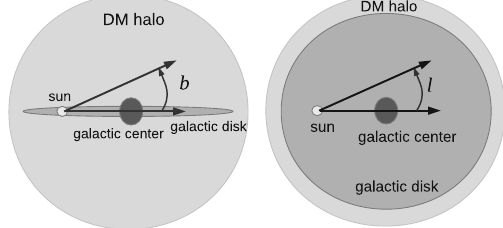
Fig. 4 Side and top schematic views of the galactic DM halo, indicat- ing the galactic coordinates l and b